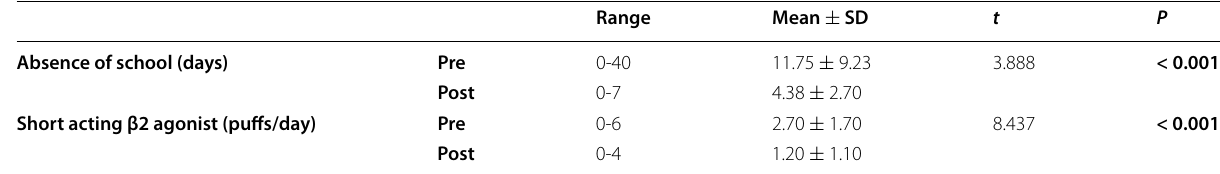
Table 4 School absence and SABA use among patients (pre-intervention and post-intervention)